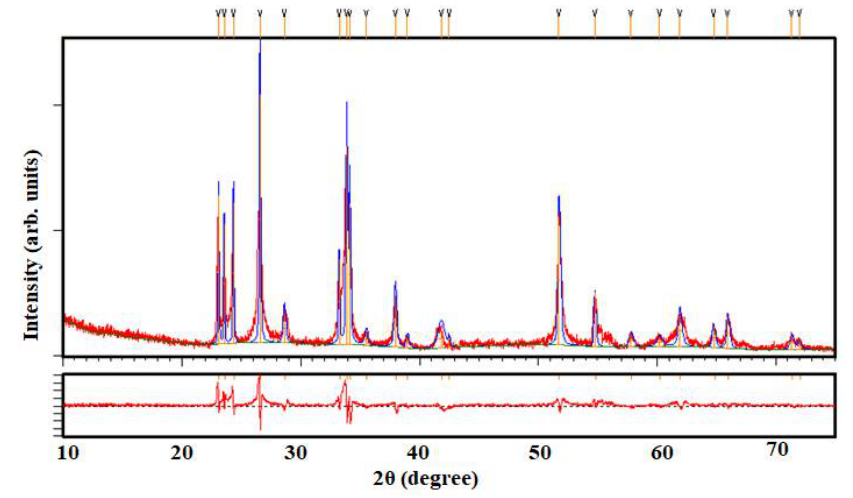
Table 1. Data obtained through Rietveld refinement of the diffraction data of β-SnWO 4.